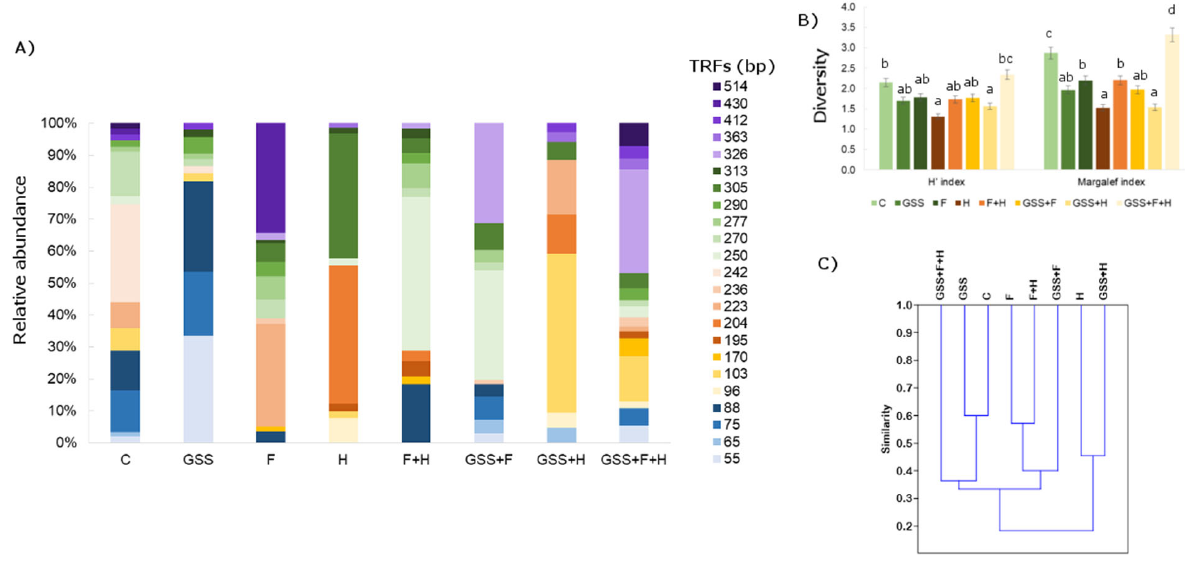
Figure 3. ( A ) Relative abundance (%) of fungal TRFs fragments in soil after MspI digestion; ( B ) Shannon (H ′ ) and Margalef diversity indexes and ( C ) dendrogram presenting Jaccard similarity index ( C ). The data presented in ( B ) are means ± SD; the same letters mean non ‐ significant differences between treatments assessed by Tukey post hoc HSD test at p < 0.05.